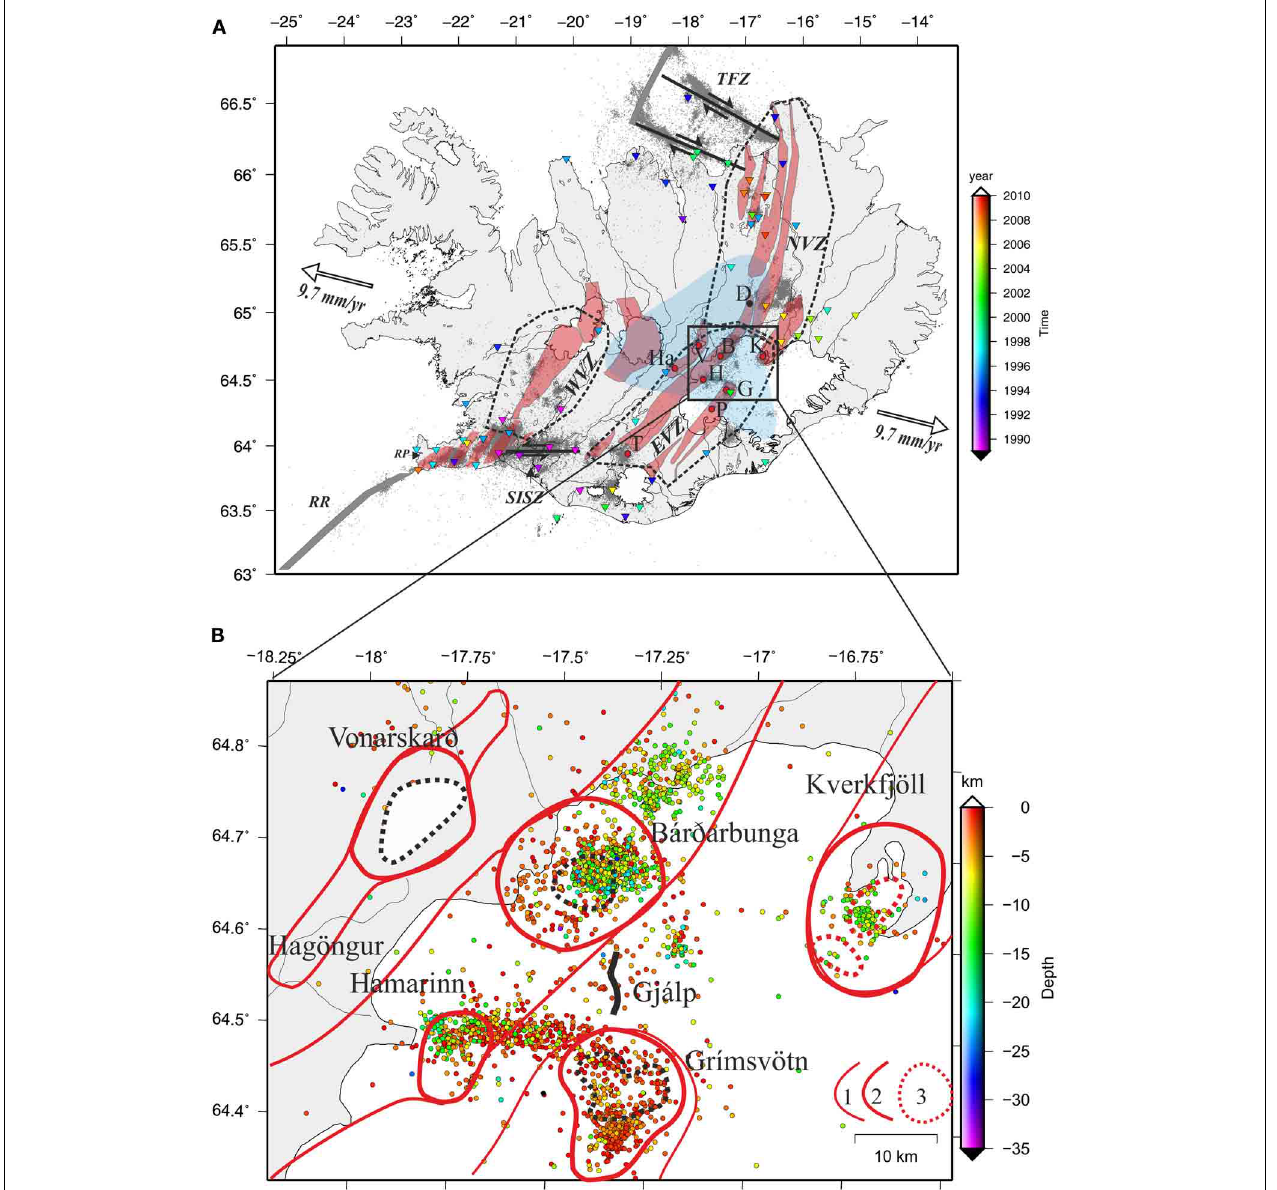
FIGURE 1 | Location of the studied area and the geodynamic context of the central part of Iceland. (A) Rift and transform zones in Iceland. Thick gray lines: offshore ocean ridge axes of the Mid-Atlantic ridge. Thick black lines: transform zones with couple of arrows indicating the sense of movement (modified after Angelier, 2002). Main Holocene volcanic systems of onshore rift zones in red with glacier left in white (after Sæmundsson, 1979; Thordarson and Larsen, 2007). Earthquakes epicenters from 1991 to 2009 provided by IMO are shown as small black dots. Apex zone of Icelandic hotspot superimposed in light blue (after